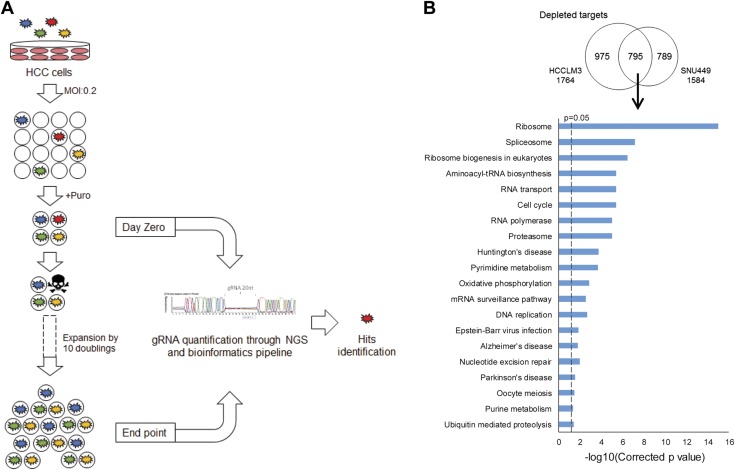
Genome-wide CRISPR depletion screen. A) Schema of the screen. Human HCC cell lines, HCCLM3 and SNU449, were transduced with a GeCKO v2 lentivirus gRNA library at an MOI of 0.2 and selected with puromycin (Puro) (4 µg/ml), and the resultant GeCKO-ready cells were allowed to grow for 10 doublings in normal growth conditions. Cells harboring gRNAs that knock out cellular targets that are important for cell growth and survival will have a disadvantage in proliferation and therefore result in the respective gRNAs being depleted from the final population. gRNAs from samples collected at end point are compared against those at d 0 using next-generation sequencing (NGS) to identify hits, which are defined as growth-promoting genes with multiple targeting gRNAs significantly depleted in end point samples. B) Hits from the CRISPR depletion screen were significantly enriched in essential cellular pathways. Top: Venn diagram showing a total of 795 hits that were commonly depleted in both HCCLM3 and SNU449 cell lines at the end of the screen. Bottom: KEGG pathway analysis showing significant enrichment in essential pathways (such as the ribosome, cell cycle, and DNA replication) among these 795 commonly depleted targets. The x axis shows the P value from a hypergeometric test adjusted by the multiple-test correction. The dashed line indicates a threshold of corrected value of P = 0.05.